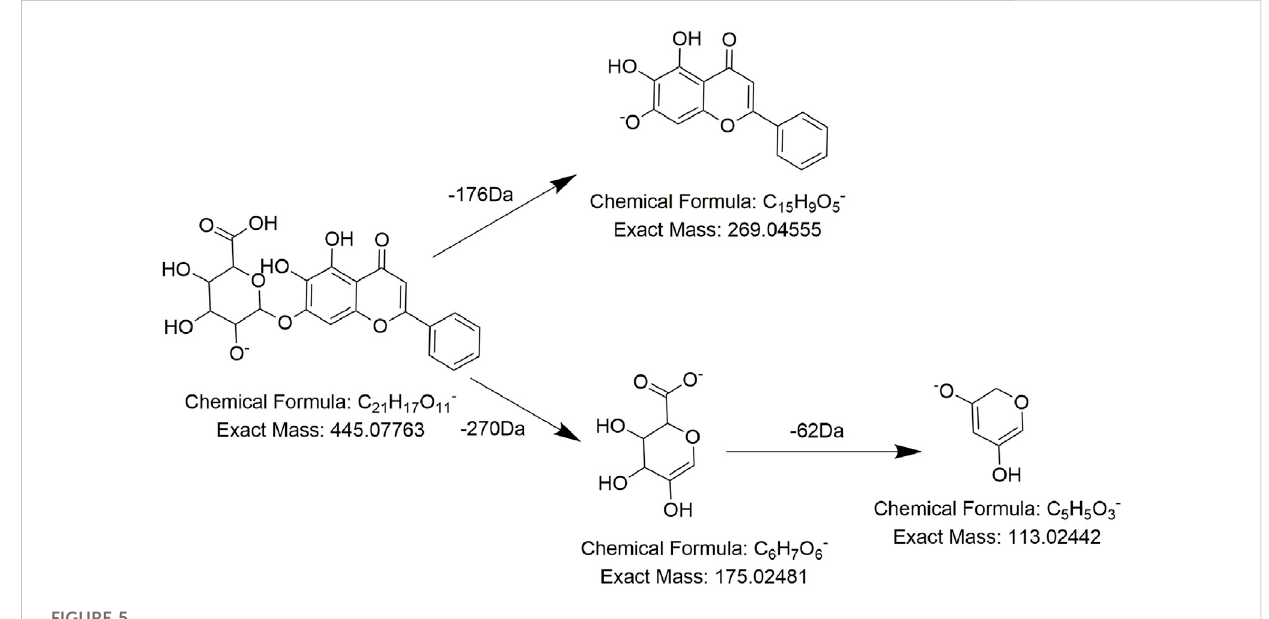
FIGURE 5 Proposed fragmentation pathways of FL20